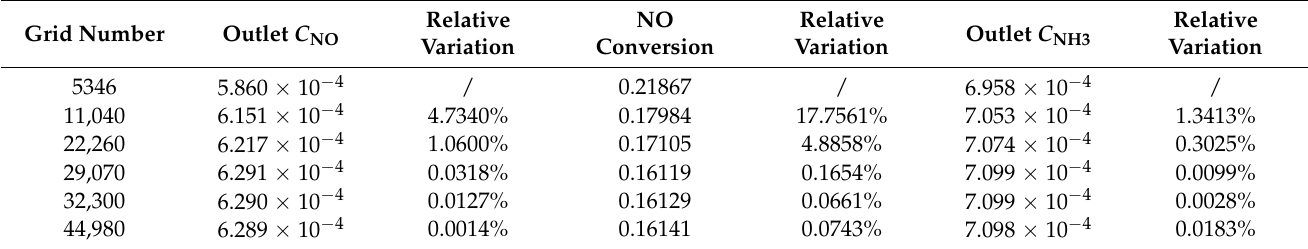
Table 6. The variation results of calculation with grid number.